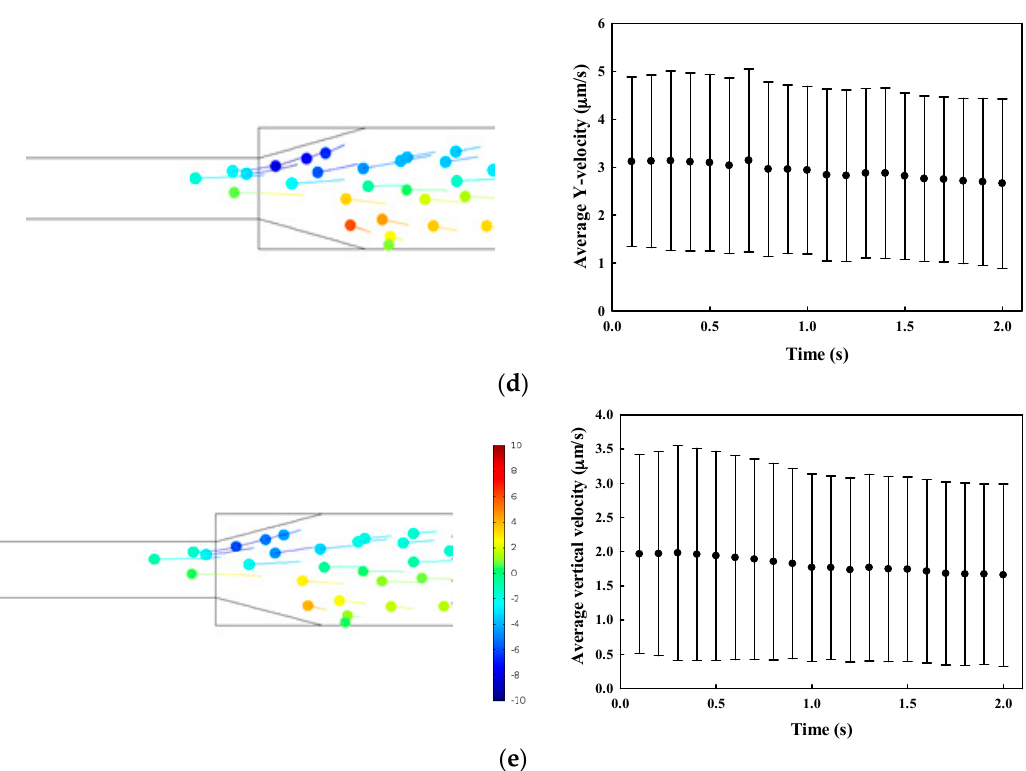
Figure 4. The motion of 30 particles at t = 1.2 s (left column) in top view and the Y-velocity of particles presented as mean ± standard deviation (STD) in μ m/s (right column) in a 100 μ m microchannel at the constriction angle of 15° with the fluid viscosity of ( a ) 8.9 × 10 − 4 Pa·s (1×) without acoustic excitation; and ( b ) 8.9 × 10 − 4 Pa·s (1×); ( c ) 8.9 × 10 − 3 Pa·s (10×); ( d ) 4.45 × 10 − 2 Pa·s (50×); and ( e ) 8.9 × 10 − 2 Pa·s (100×) with the actuation of the standing surface acoustic wave at the vibration amplitude of 0.94 nm.